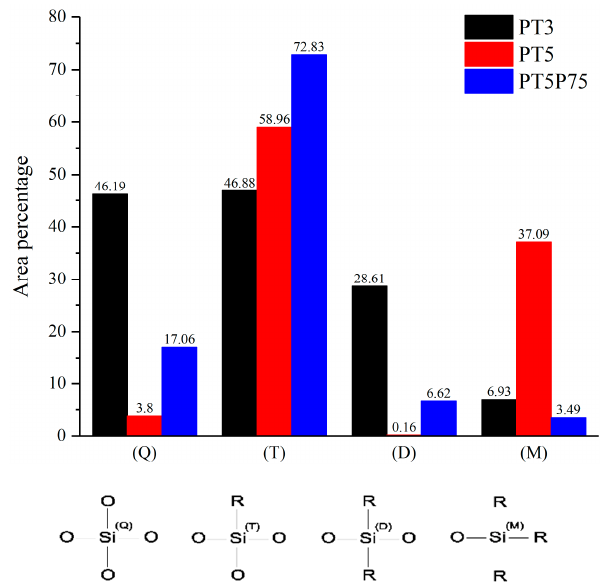
Figure 13. Component quantification of siloxane-based coatings determined through high resolution spectroscopy of Si 2p core peak.